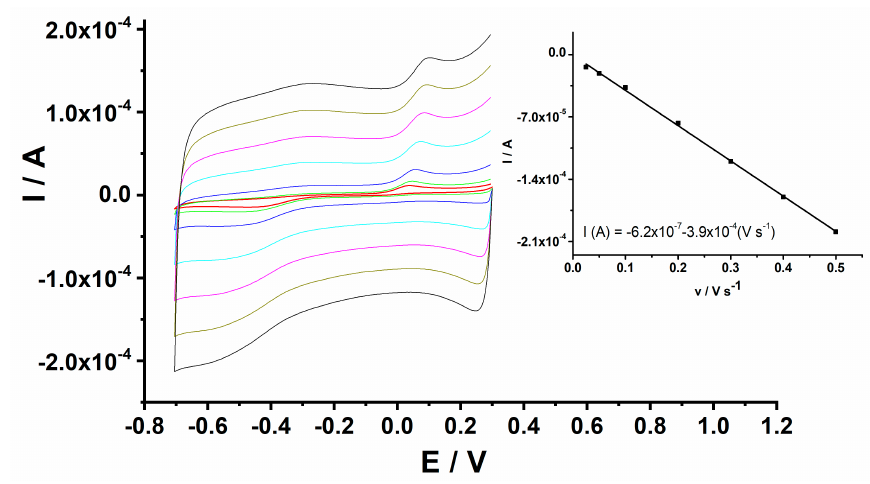
Figure 8. CVs for GCE/PEDOT-CuONPs in 0.1 M NaOH containing 1 mM H 2 O 2 recorded at various potential scan rates of 0.025, 0.05, 0.1, 0.2, 0.3, 0.4, and 0.5 V s − 1 . Inset: linear dependence of the cathodic peak current versus the potential scan rate.